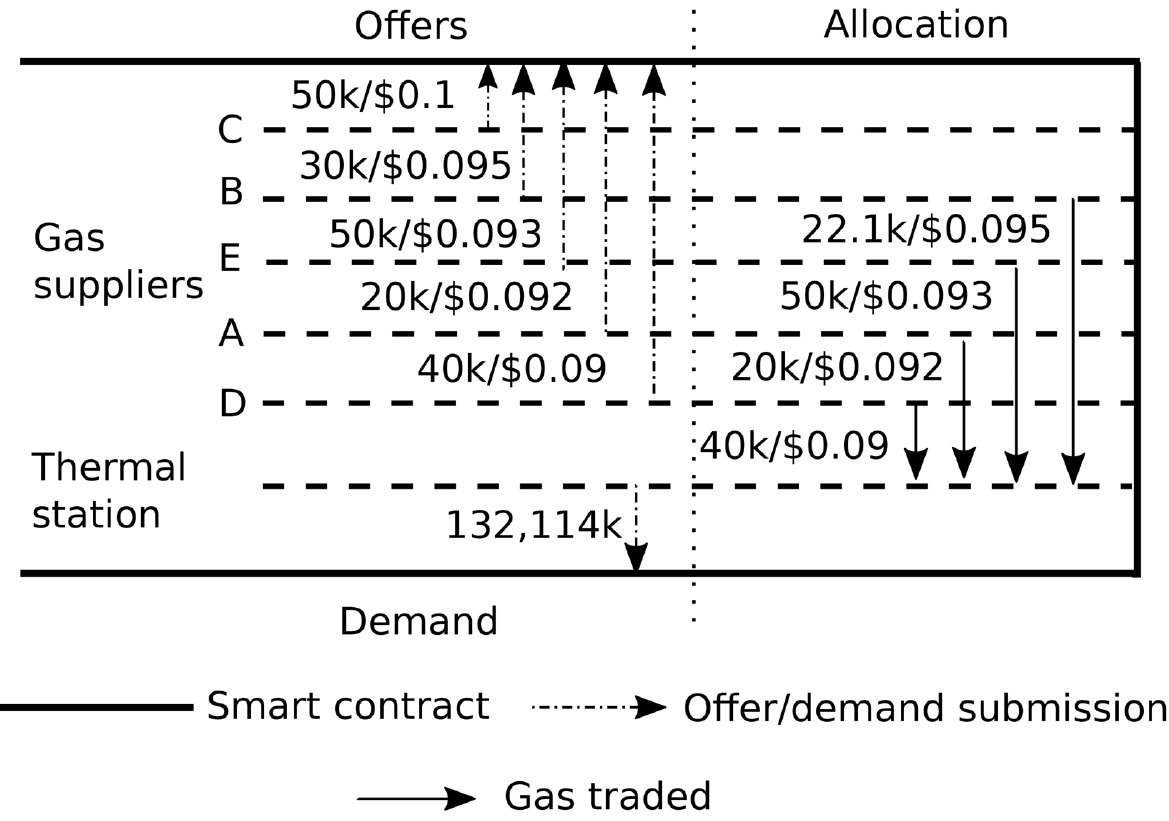
Figure 3. Smart contract execution of P2P gas trading.